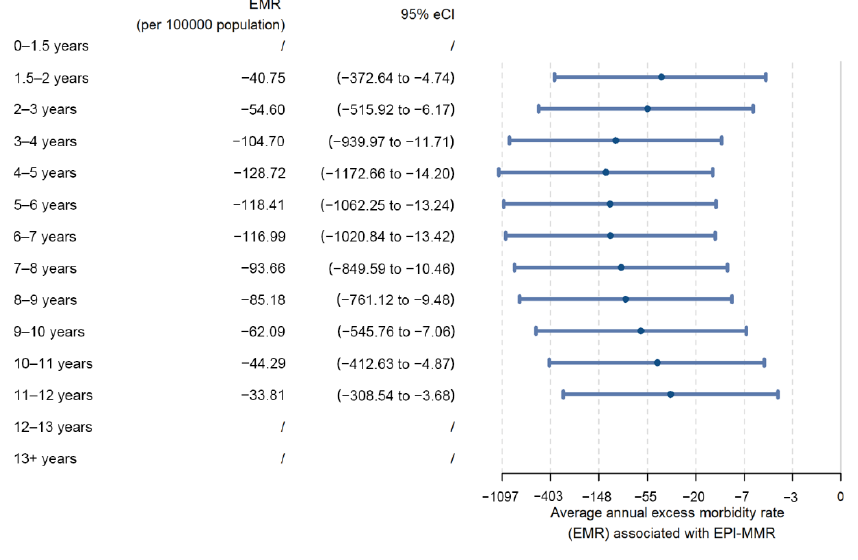
Figure 3. Average annual excess mumps morbidity rate associated with the EPI-MMR intervention in Guangzhou,